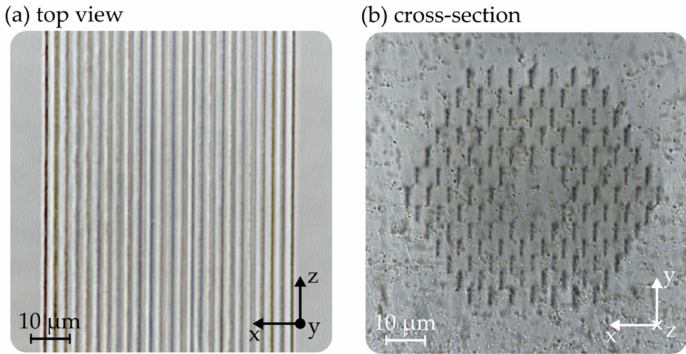
Figure 3. Bright-field microscopy images of a sapphire photonic crystal waveguide with 5 µ m modification distance: ( a ) top view; ( b )